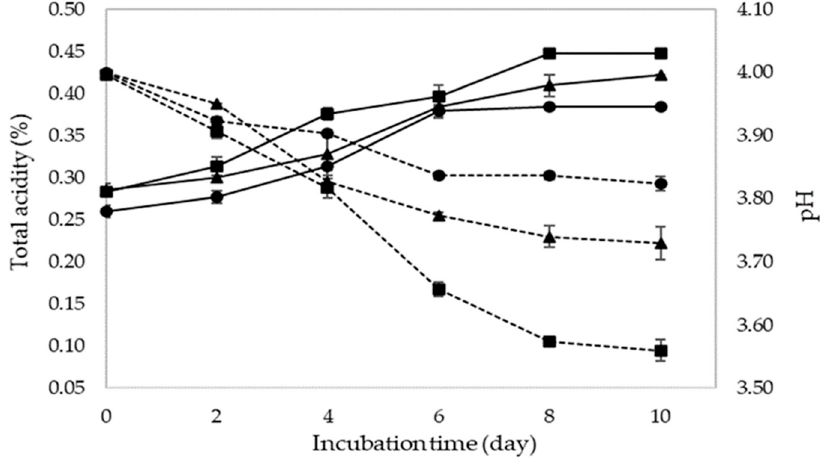
Figure 2. Total acidity (solid line) and pH (dash line) of pineapple juice and water at a ratio of 2:1 ( █ ), 1:1 ( ▲ ), and 1:2 ( ● ) during wine fermentation.